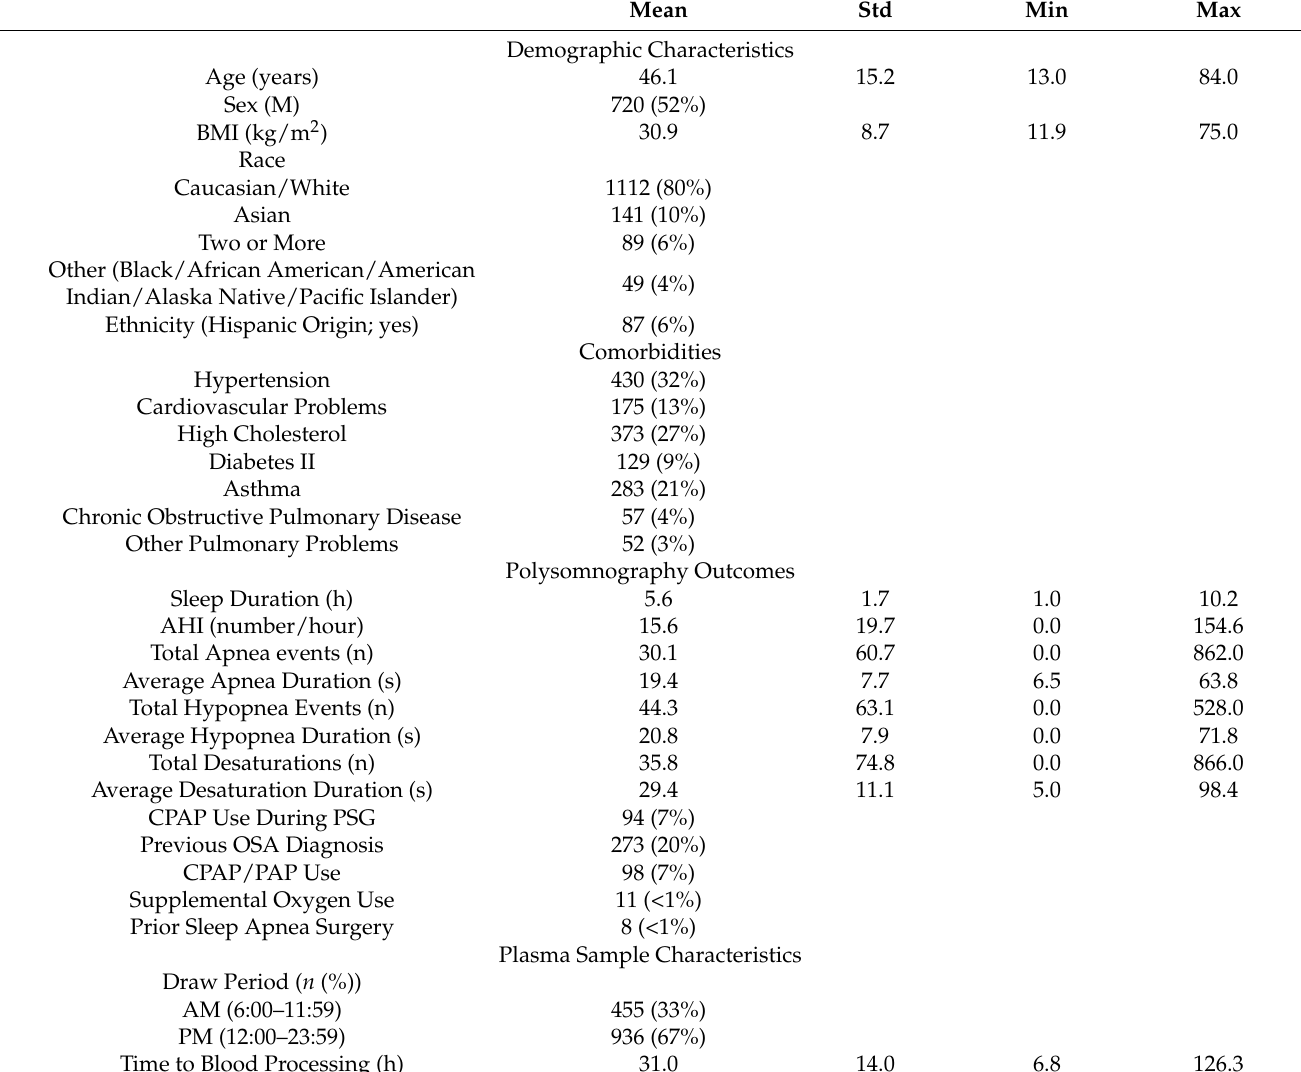
Table 1. Demographic and clinical characteristics of participants included in final analyses ( n = 1391). Mean Std Min Max Demographic